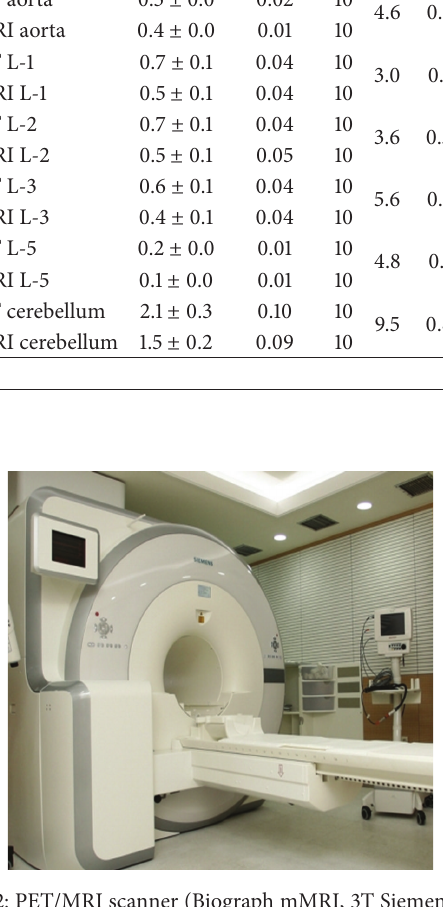
Figure 2: PET/MRI scanner (Biograph mMRI, 3T Siemens, Erlan- gen,